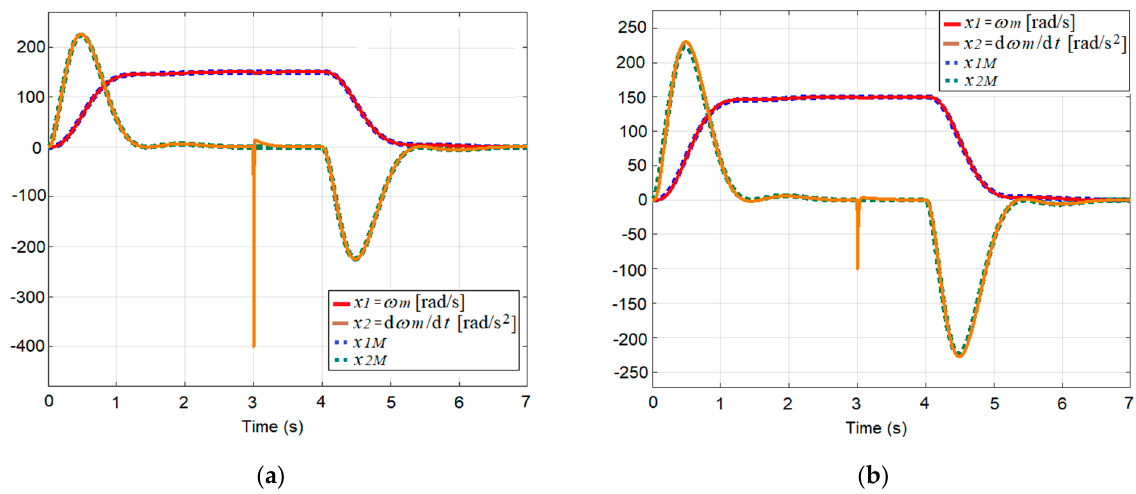
Figure 7. The effect of change of additional moment of inertia to the value: ( a ) J = 0.5 J N ; ( b ) J = 2 J N on control dynamics at motor starting and loading.